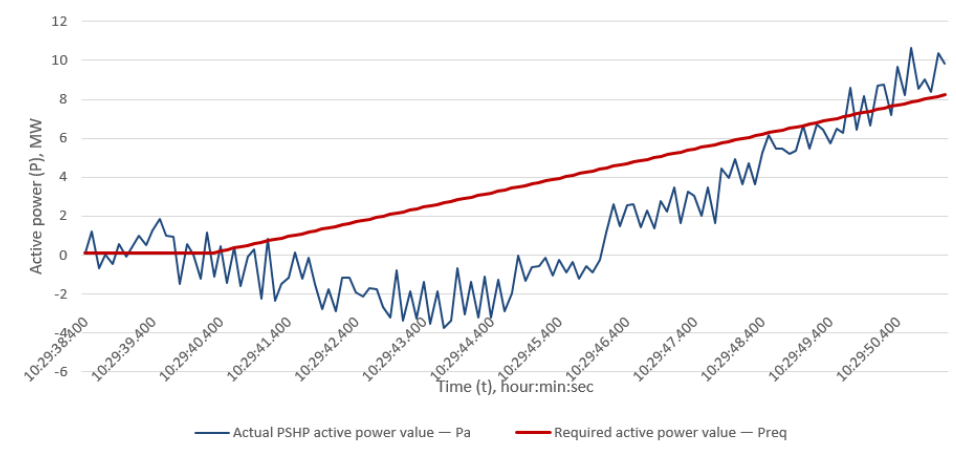
Figure 4. Representation of the PSHP transition process.